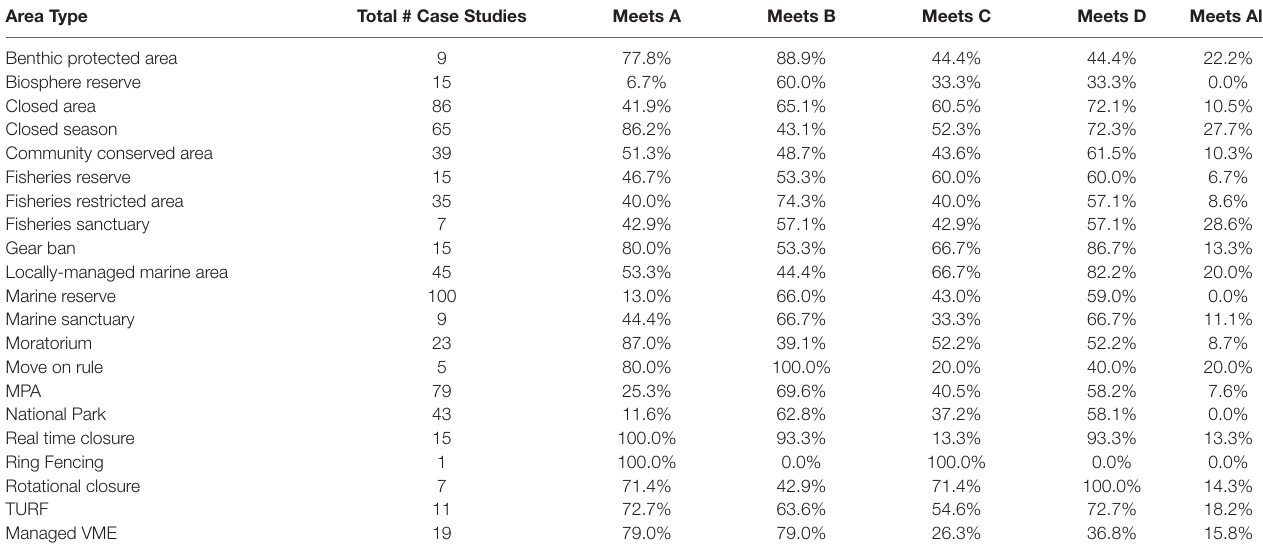
TABLE 3 | Percentage of case studies that meet each OECM criterion by ABMT type. Area